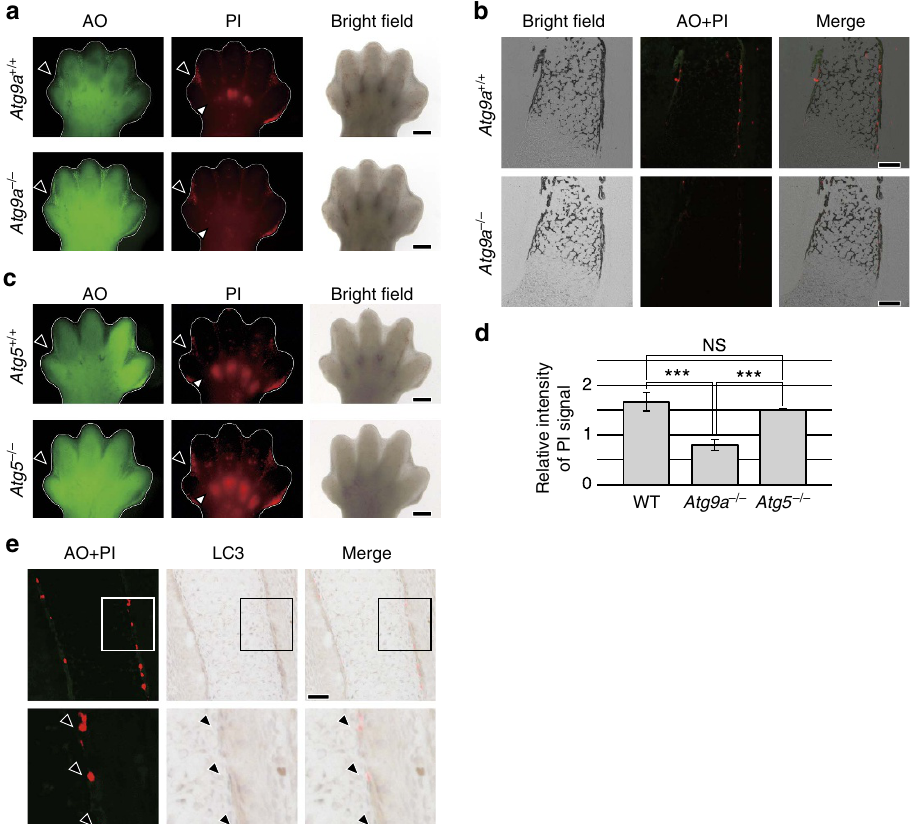
Figure 4 | Lack of PI foci at the bone surface in Atg9a KO embryos. ( a ) Atg9a KO embryos had no PI foci in the phalanges, but these foci persisted in the interdigital regions. At E14.5, an Atg9a KO ( Atg9a (cid:2) / (cid:2) ) embryo and a control ( Atg9a þ / þ ) embryo were injected with AO and PI, after which the right hind limb buds were observed by fluorescence stereomicroscopy. Black and white arrowheads indicate the first interdigital regions and phalangeal areas, respectively. Scale Bar, 400 m m. ( b ) PI foci were not observed in the ulna at a later stage of Atg9a KO embryo. Fluorescence microscopy of a vertical cryosection of the forelimb zeugopod of an E15.5 embryo injected with AO and PI. The black foci in bright fields correspond to calcified areas. Scale bar, 100 m m. ( c ) PI foci in the phalanges of an Atg5 KO embryo. At E14.5, an Atg5 KO ( Atg5 (cid:2) / (cid:2) ) embryo and a control ( Atg5 þ / þ ) embryo were injected with AO and PI, and the right hind limb buds were observed by fluorescence stereomicroscopy. ( d ) Bar graphs showing quantitative assessment of PI signals in the phalanges. The relative intensity of PI signals in the phalangeal area was calculated as the PI signals in the area divided by the PI signals in the palmar region. Data are represented as the mean ± s.d.; n ¼ 8 for wild-type (WT) embryos, n ¼ 5 for Atg9a (cid:2) / (cid:2) embryos and n ¼ 4 for Atg5 (cid:2) / (cid:2) embryos. *** P ¼ 0.0000016 and P ¼ 0.0000052 for comparison between Atg9a (cid:2) / (cid:2) embryos and WT embryos or Atg5 (cid:2) / (cid:2) embryos, respectively, by the two- tailed Student’s t -test. NS: P ¼ 0.13 for comparison between Atg5 (cid:2) / (cid:2) and WTembryos. ( e ) LC3 punctae were not observed in PI-positive cells. A vertical cryosection of the forelimb of an E14.5 embryo injected with AO and PI was subjected to immunostaining with an anti-LC3 antibody. Scale bar, 50 m